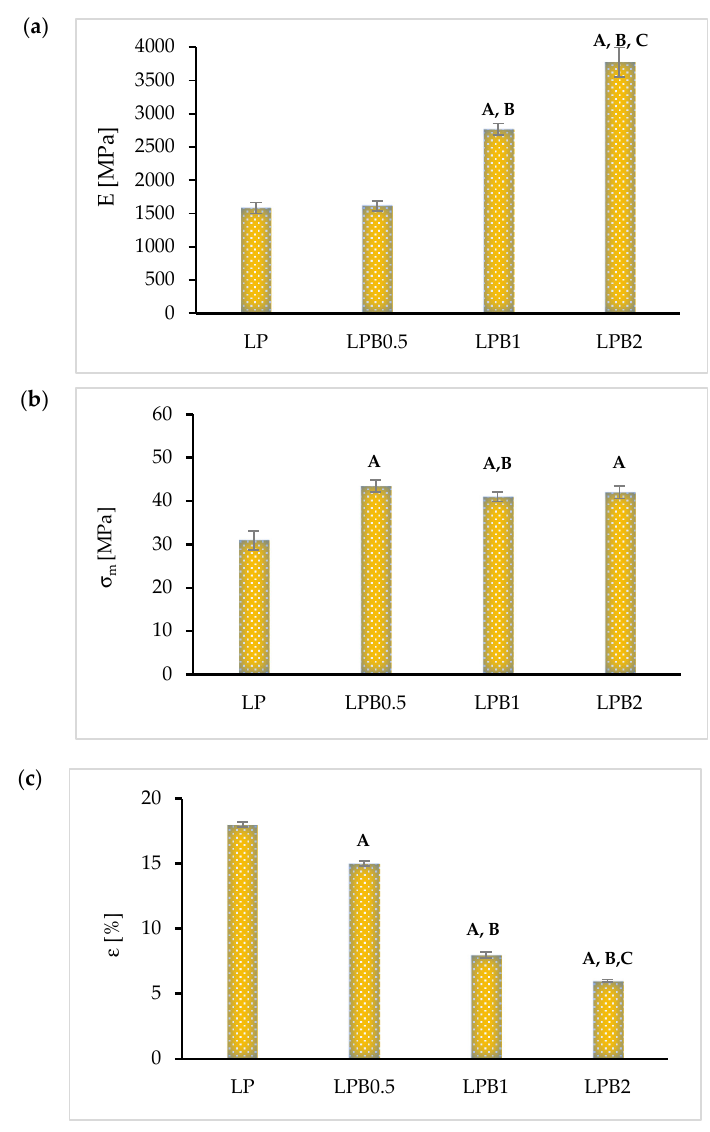
Figure 6. Values of mechanical properties of obtained films: ( a ) Young’s Modulus (E), ( b ) tensile strength ( σ m ), ( c ) elongation at break ( ε ). ( p < 0.05, statistically significant differences in comparison: A—to LP film, B—to LPB0.5 sample, C—to LPB1 material).